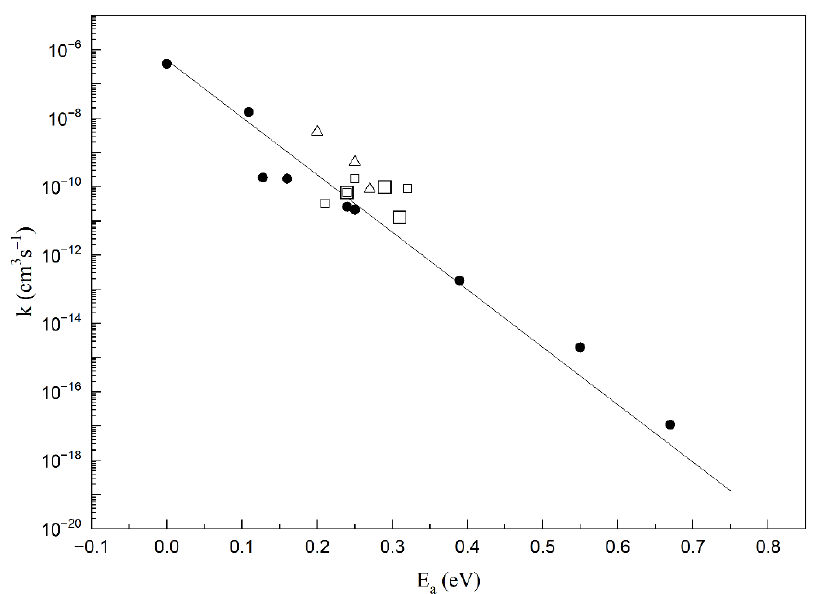
Figure 8. Thermal electron attachment rate coefficients as a function of the activation energies: (Δ)— present data; our previous data for: (□)— chlorinated silanes; (●)— chlorinated alkanes (values from Table 1). Solid line — theoretically obtained values of the rate coefficients for T = 298 K considering the electron as the de Broglie wave.